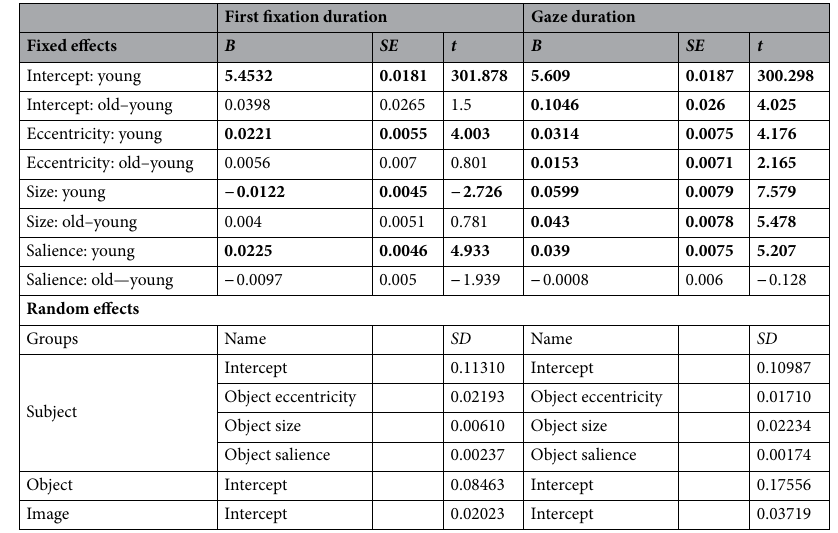
Table 3. Fixation times for objects in scenes. Significant coefficients are set in bold (| t |> 1.96). Results from two linear mixed models, fitting log-transformed first-fixation durations and gaze durations on